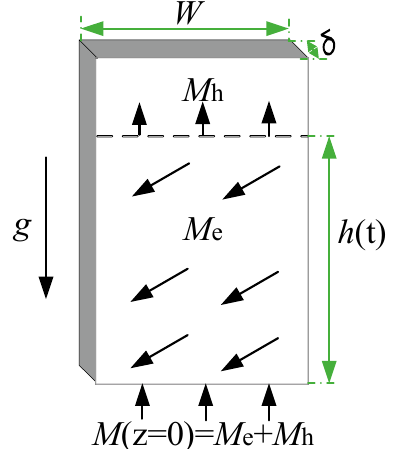
Figure 2. Mass balance of a wicking process with evaporation.